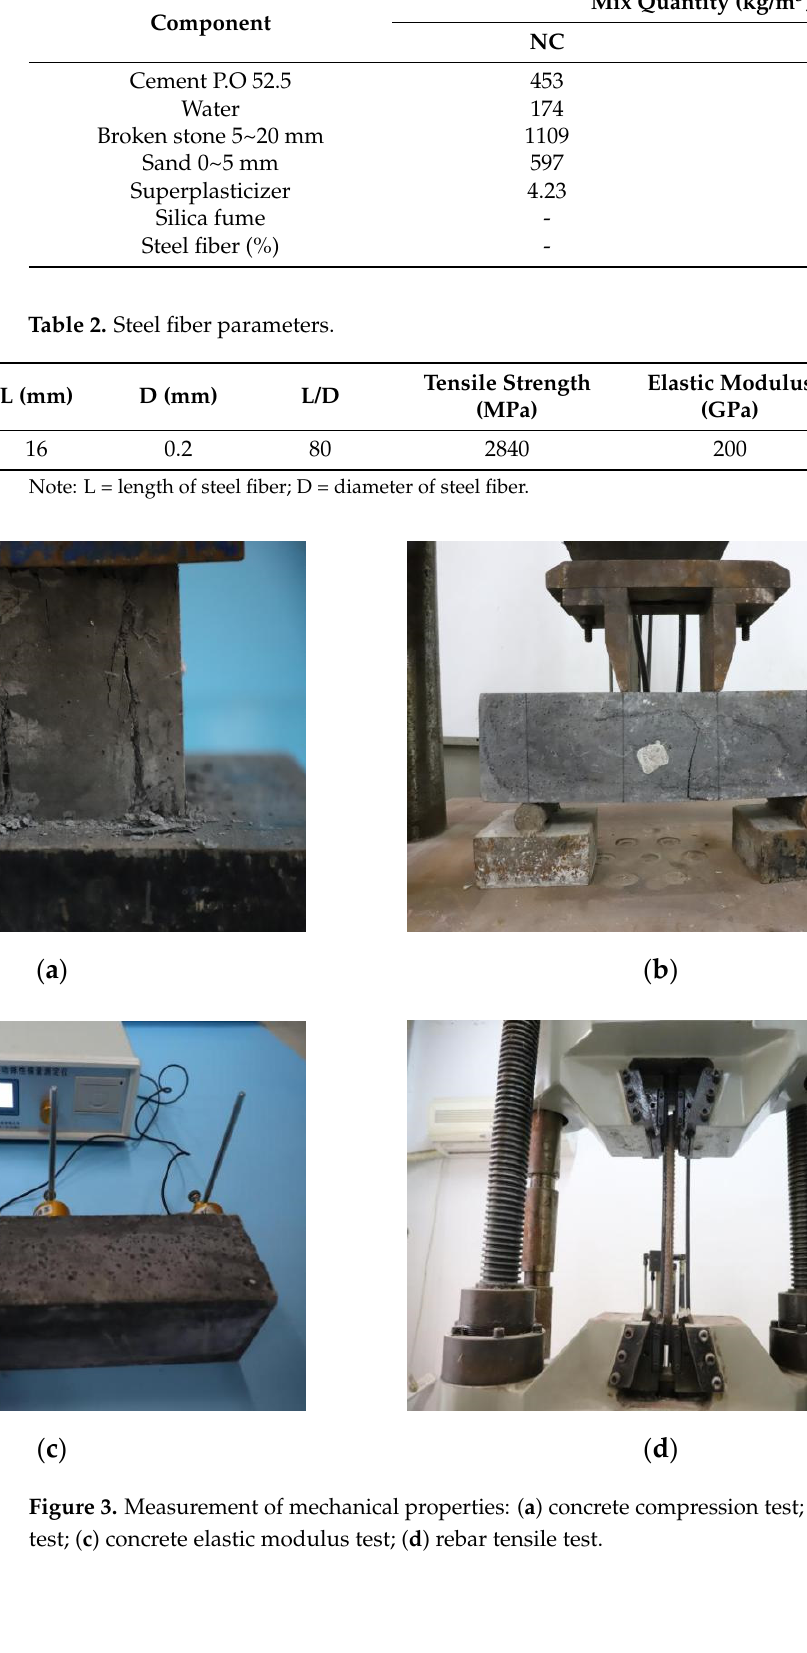
Table 1. The mixture proportions of concretes.